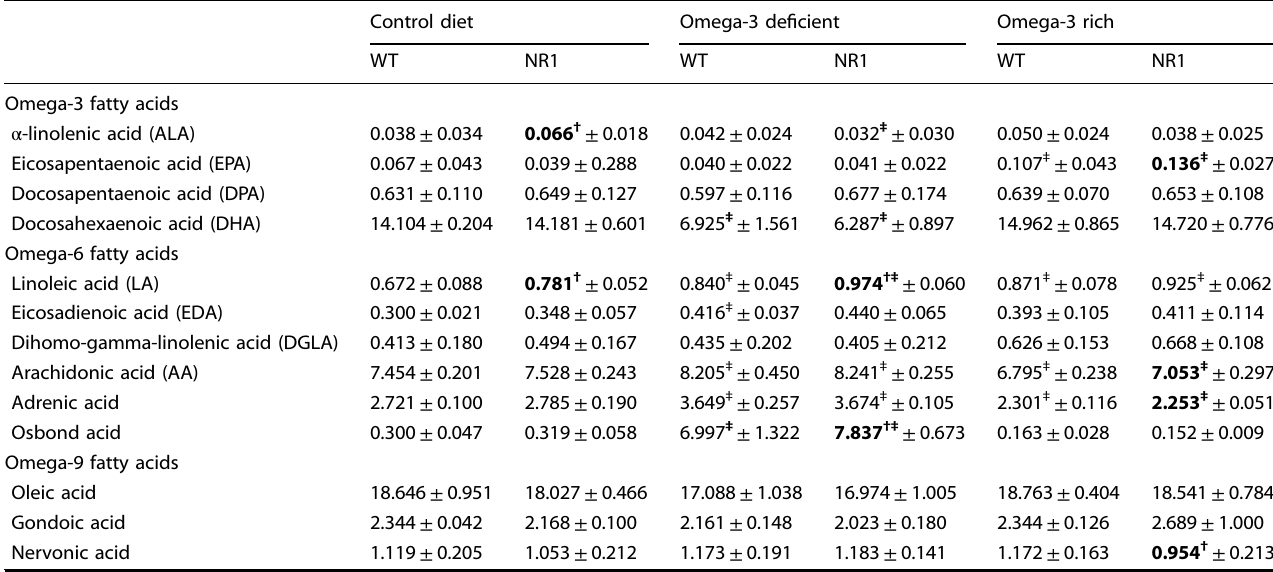
Table 1. Brain fatty-acid pro fi le of WT and NR1KD mice on experimental